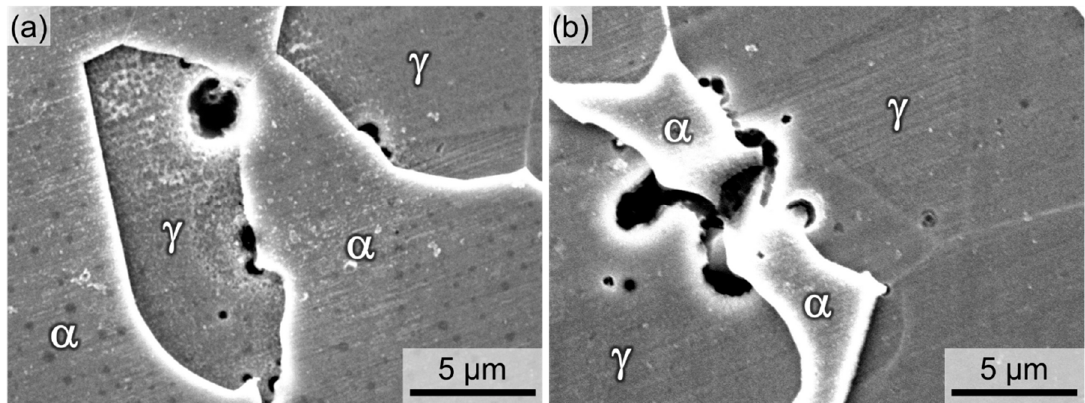
Figure 7. Pit morphologies of ( a ) Ni03 and ( b ) Ni57 alloys after immersion in a 1 M HCl + 2 M NaCl solution at 40 °C for 30 min.